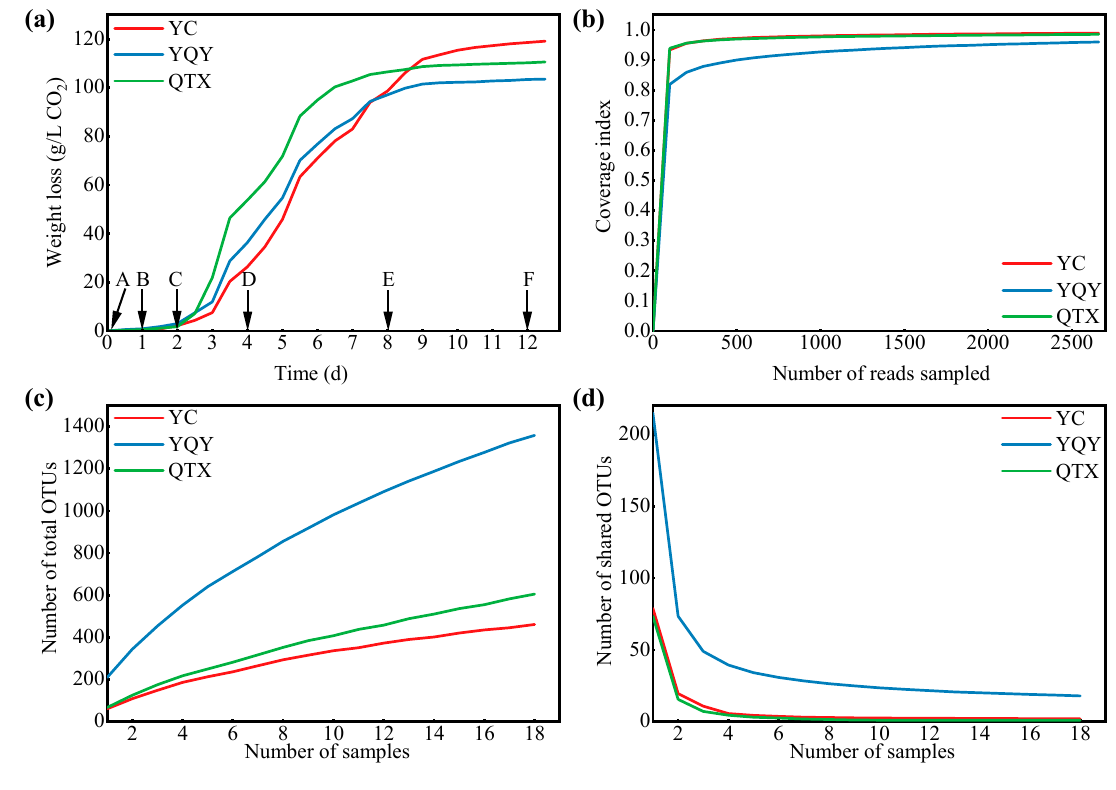
Figure 1. The fermentation process and sequencing evaluation. ( a ) The release of CO 2 of three spontaneous fermentations. Samples were collected at six points marked with A (0 d), B (1 d), C (2 d), D (4 d), E (8 d), and F (12 d); ( b ) the rarefaction curve: X -axis, sequenced reads per sub-region; Y -axis, the percentage of discovered bacteria to predicted total bacteria per sub-region; ( c ) the observed numbers of bacteria per sub-region; ( d ) the shared numbers of bacteria among three sub-regions. OTUs, operational taxonomic units. Sequences with more than 97% similarity were classified as one OTU.